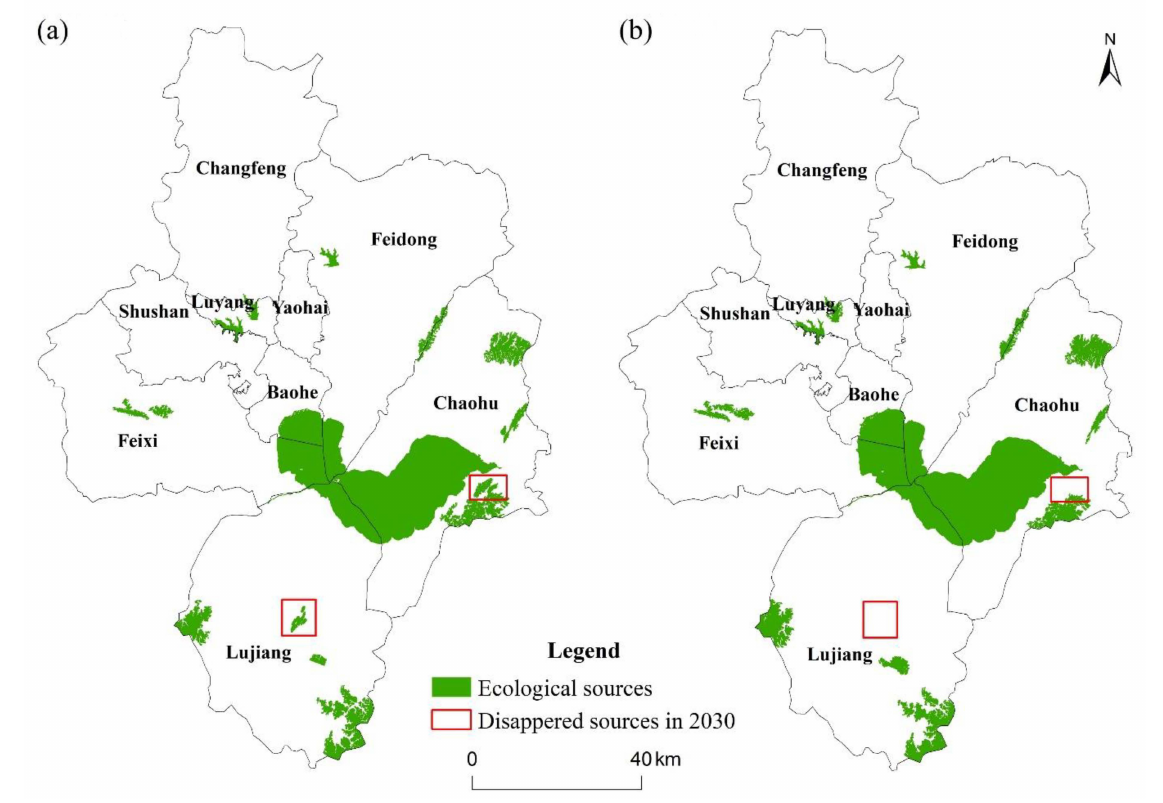
Figure 3. Ecological sources of Hefei for ( a ) 2020 and ( b ) 2030. Note: The areas depicted by the red frames are ecological sources in 2020, and the portions that would be removed in 2030 because they failed to meet the ecological source screening